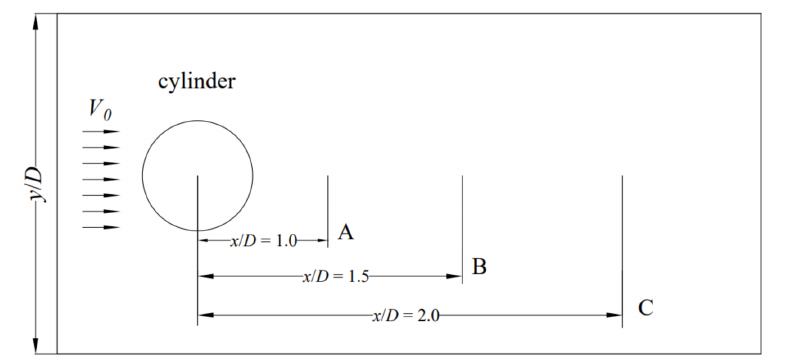
Figure 6. Schematic diagram of wake velocity extraction location.